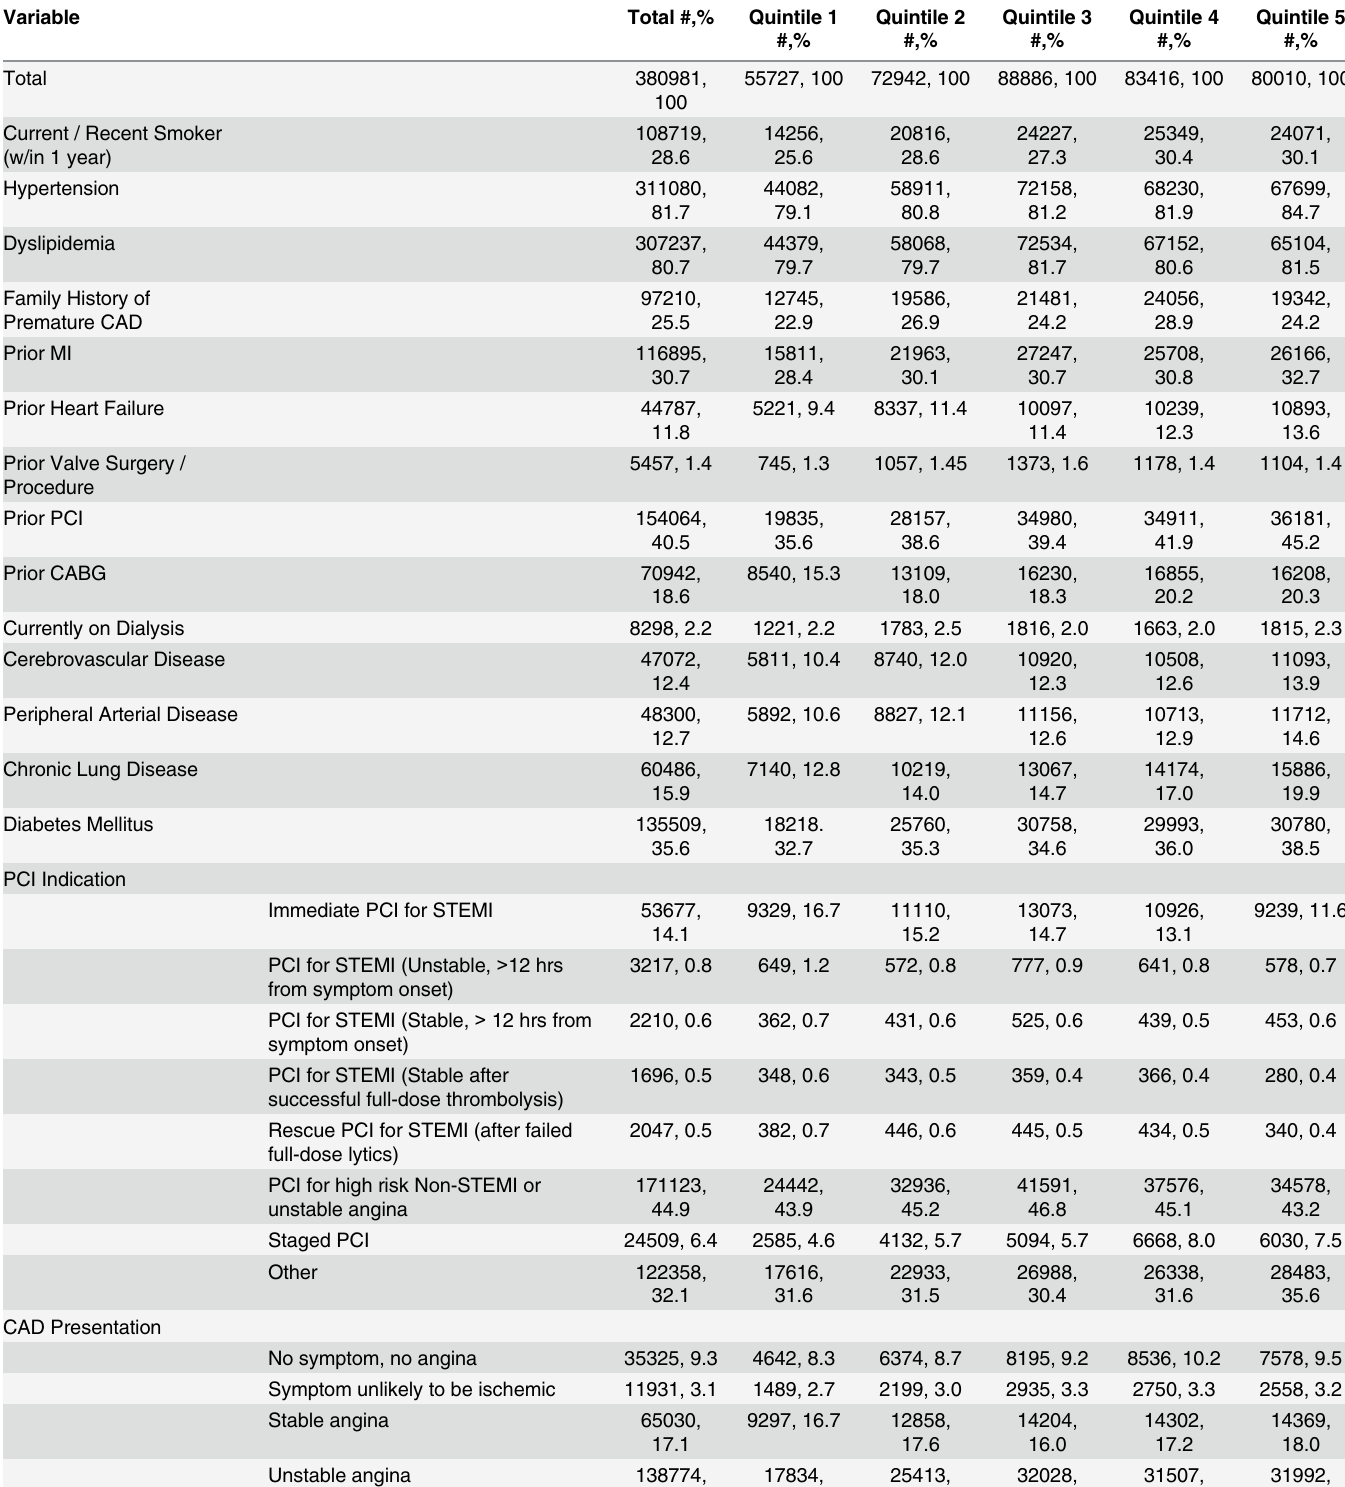
Table 3. Baseline clinical characteristics of all patients stratified by quintile of PCI rate.